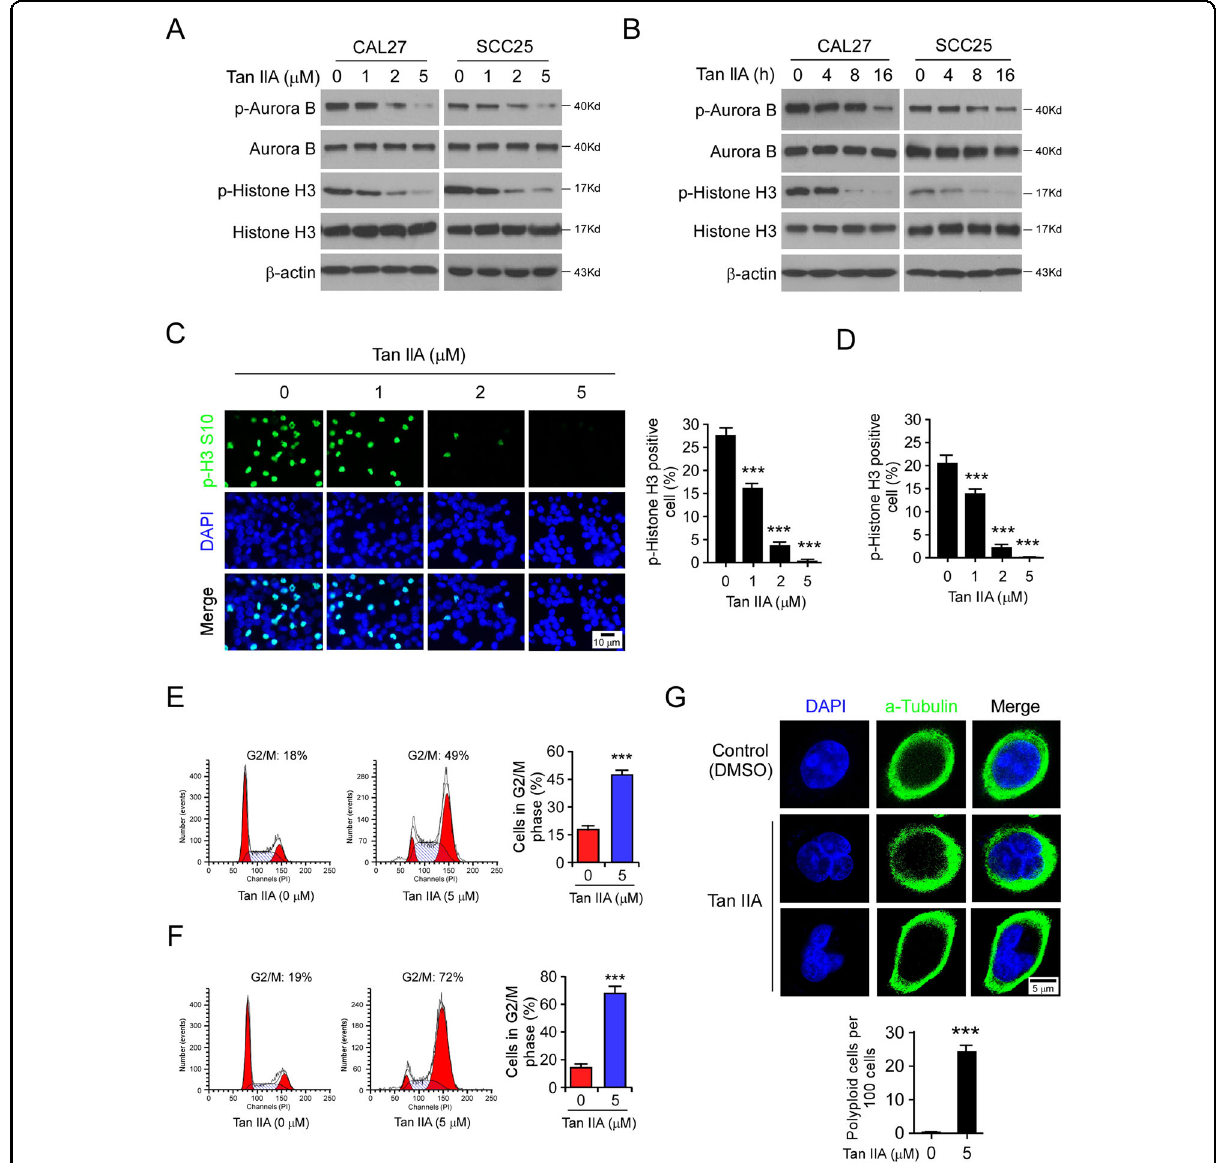
Fig. 4 Tan IIA inhibits Aurora B activity and induces G2/M phase cell cycle arrest in OSCC cells. A IB analysis of p-Aurora B and p-Histone H3 Ser10 in Tan IIA-treated CAL27 and SCC25 cells with various doses for 24 h. B IB analysis of p-Aurora B and p-Histone H3 Ser10 in 2 μ M Tan IIA-treated CAL27 and SCC25 cells for different time points. C and D Immuno fl uorescence (IF) analysis of the phosphorylation of Histone H3 Ser10 in Tan IIA- treated CAL27 ( C ) and SCC25 cells ( D ); n = 3 independent biological replications, one-way ANOVA. *** p < 0.001. Scale bar, 10 μ m. E and F Cell cycle analysis by fl ow cytometry of Tan IIA-treated CAL27 ( E ) and SCC25 cells ( F ); n = 3 independent biological replications, Student ’ s t test. *** p < 0.001. G IF analysis of the population of polyploidy cells in CAL27 cells treated with Tan IIA for 48 h. Scale bar, 5 μ m; n = 3 independent biological replications, Student ’ s t test, *** p <